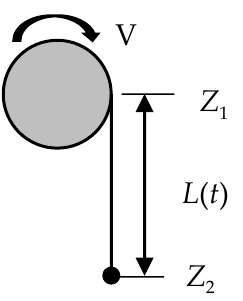
Figure 1. Simulation of wire in AQWA.